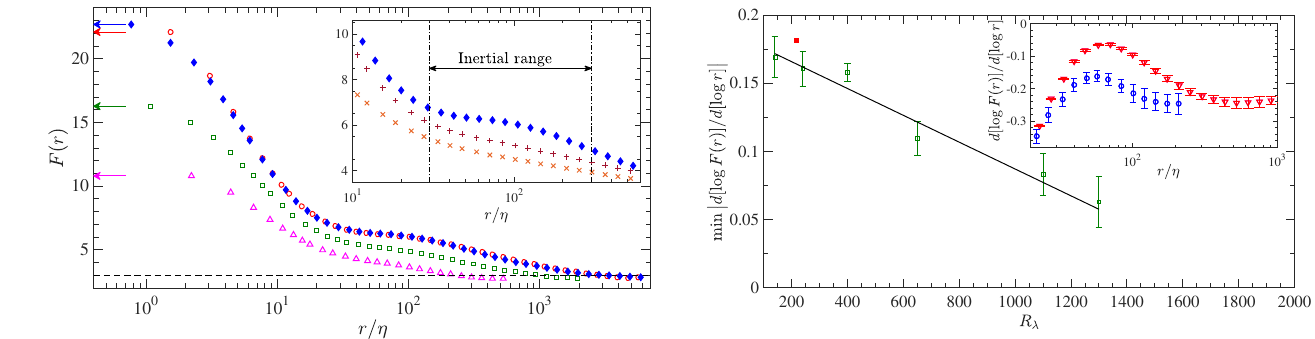
FIG. 10. Circulation flatness F ð r Þ versus spatial separation r from DNS at R λ ¼ 240 , 512 3 (triangle), R λ ¼ 650 , 4096 3 (square), and R λ ¼ 1300 , 8192 3 (circle). The flatness from the DNS at R λ ¼ 1300 computed on a 16384 3 box is also shown (filled diamond) and agrees well with F ð r Þ from the 8192 3 box, for r= η > 10 . Arrows on the ordinate show the limit F ð r → 0 Þ ¼ h ω 4 i = h ω 2 i 2 , which is the flatness of the vorticity component normal to the circulation plane. At the largest scales, F ð r Þ is close to the Gaussian flatness of three (see dashed line). Inset compares the circulation flatness with those of the longi- tudinal (times) and transverse (plus) velocity increments at R λ ¼ 1300 in the inertial range within the dashed vertical lines. Unlike circulation with a tendency towards constancy in the inertial range, the velocity increments show no tendency towards con- stancy in IR.